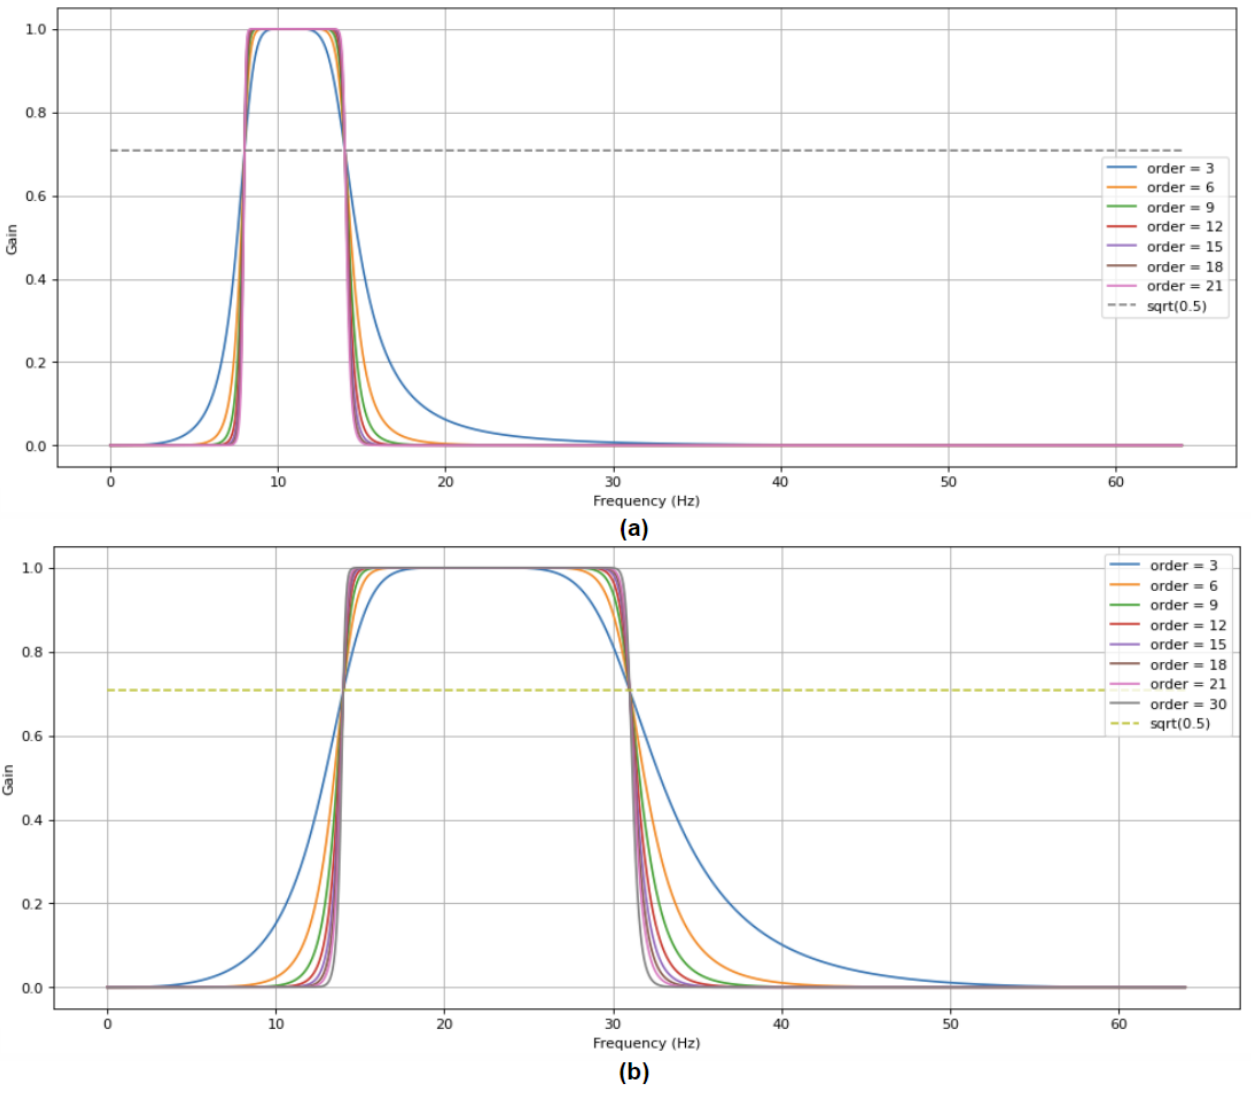
Figure 1. The effect of different orders of Butterworth band-pass filter ( a ) on Alpha frequency band and ( b ) on Beta frequency band.